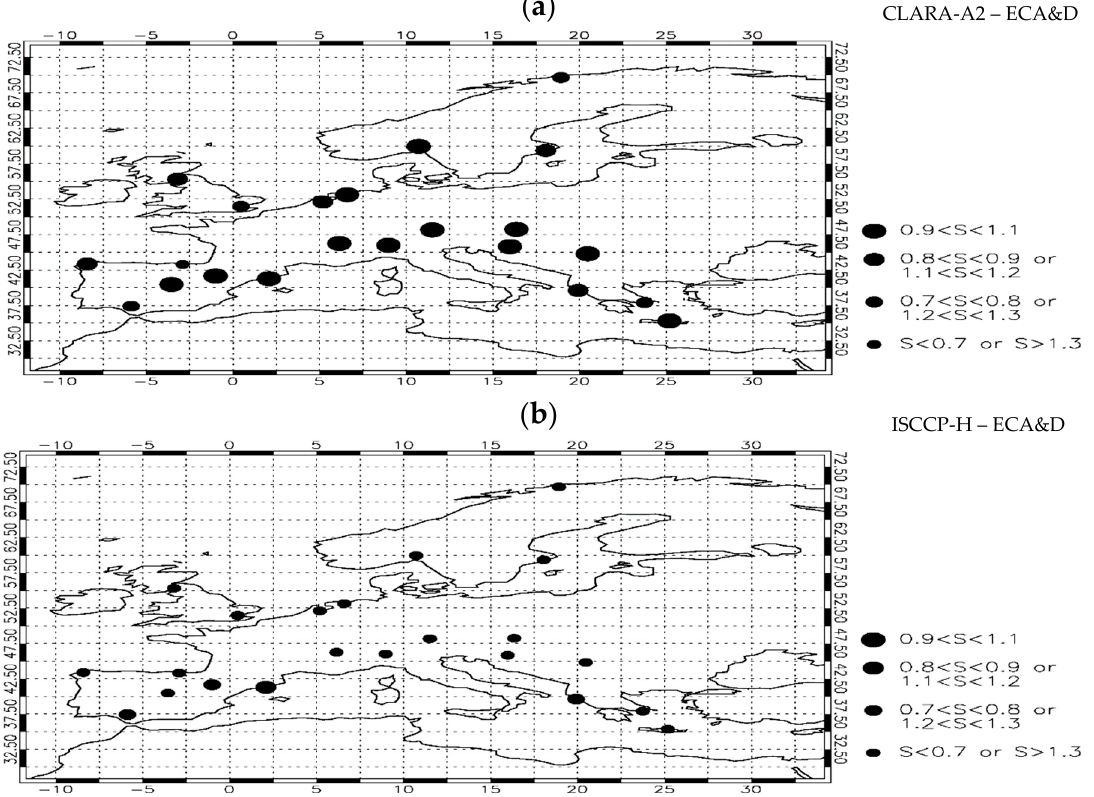
Figure 6. Same as in Figure 5, but for the slope of the linear regressions applied to the scatter plots, having the satellite-based TCC on the y axis and the ground-based TCC on the x axis.